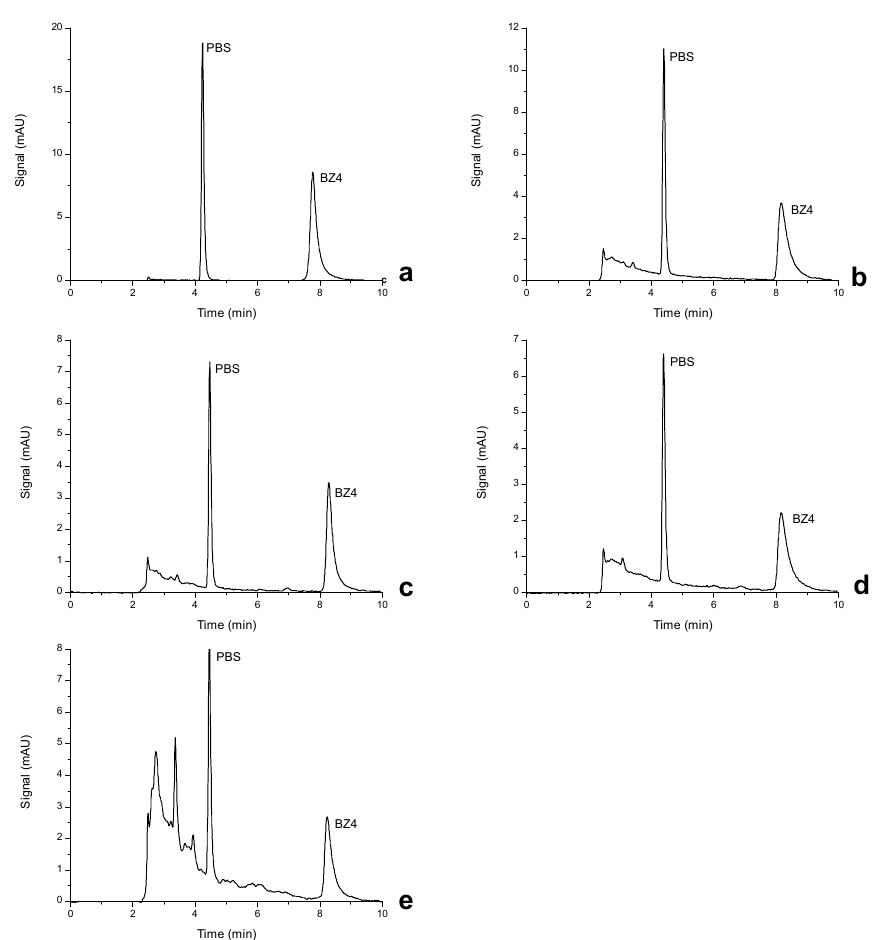
Figure 3. Chromatogram profiles obtained from assays performed in spiked ultra-pure ( a ), tap ( b ), sea ( c ) and estuarine water ( d ), as well as wastewater ( e ) samples by BA µ E(PS-DVB)- µ LD / HPLC–DAD, under optimized experimental conditions.